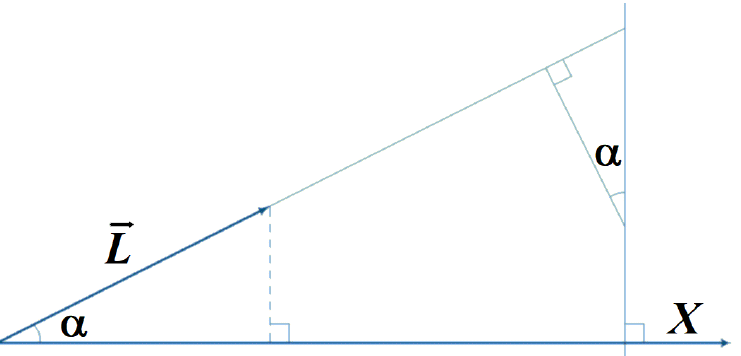
Figure 1. The origin of two